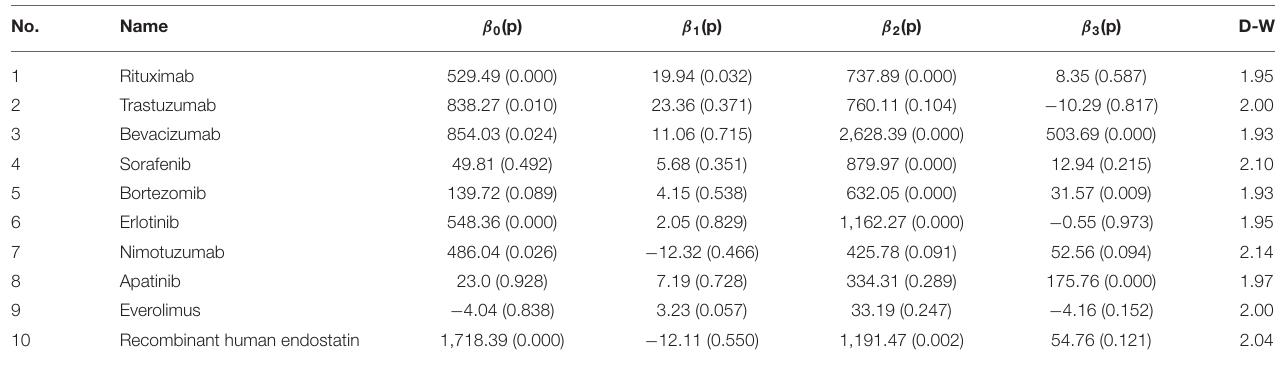
TABLE 5 | Changes in the trend and level of utilisation estimated by ITS regression